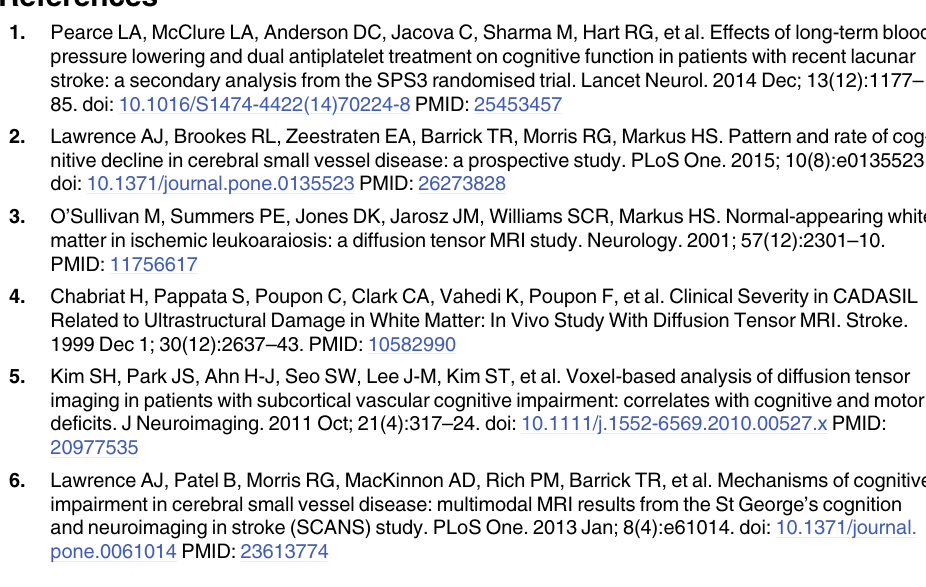
S1 Table. Progression of DTI parameters within white matter hyperintensities calculated through linear mixed effect models. S2 Table. Progression of mean diffusivity values within CSF